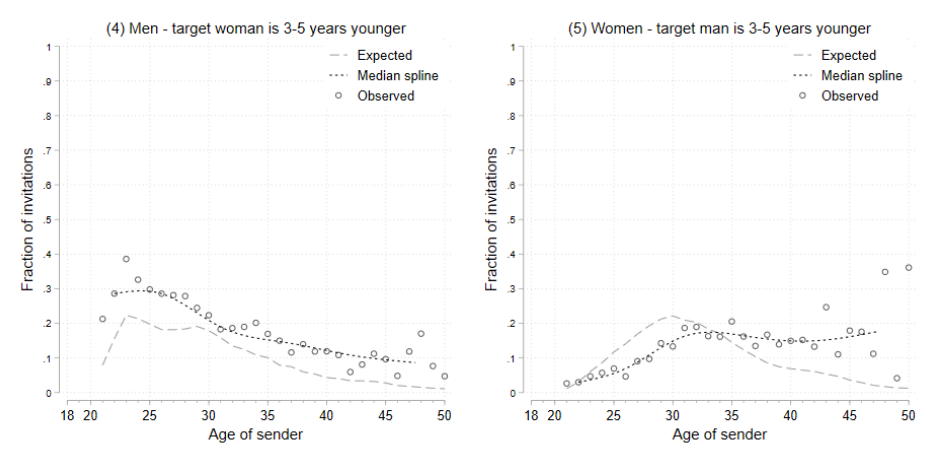
Figure 4 and 5 : Observed and expected fractions of initial messages sent to 3-5 years younger